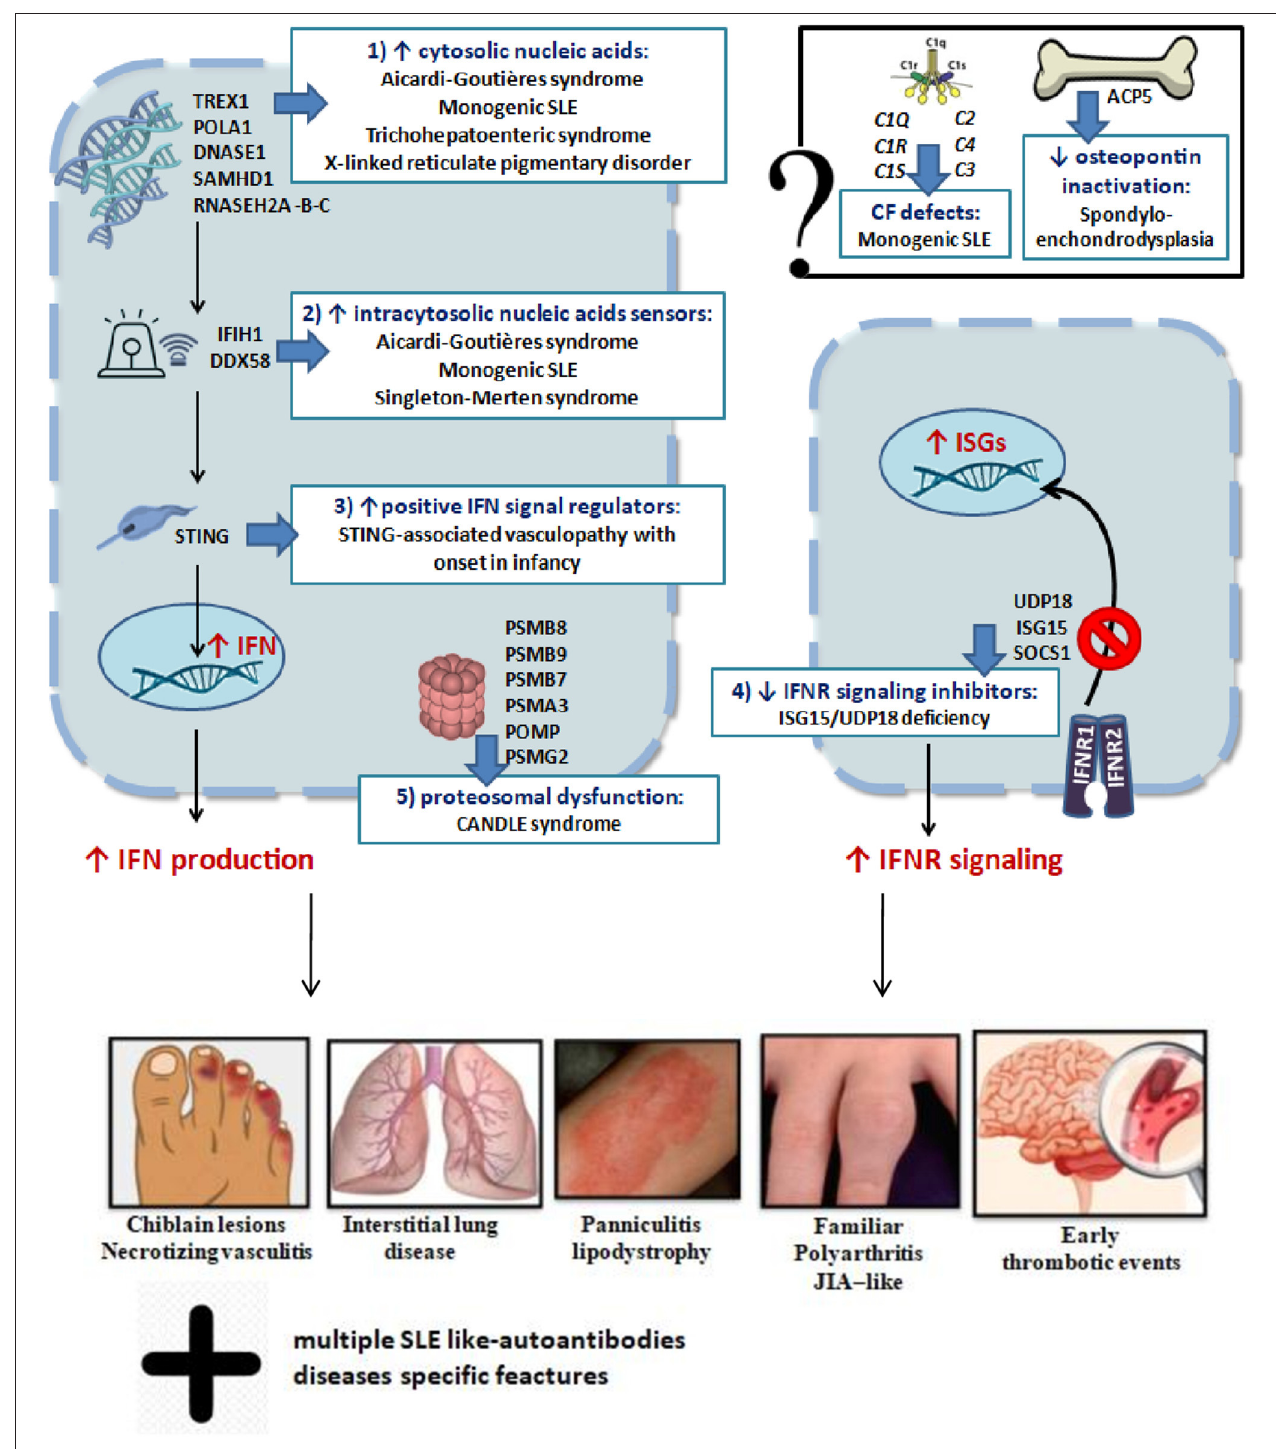
FIGURE 2 | Schematic representation of genetic mechanisms and clinical manifestations in main interferonopathies (see in the